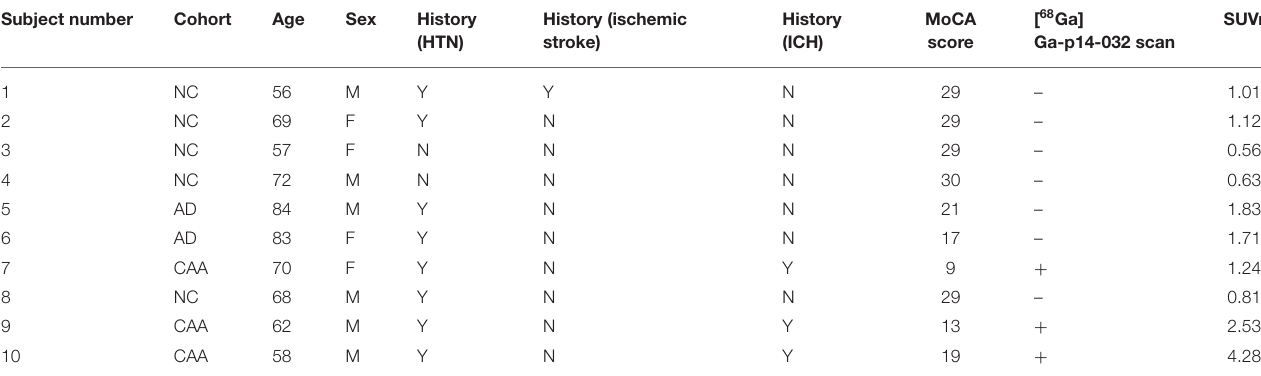
TABLE 1 | Demographics of CAA, AD, normal patients.